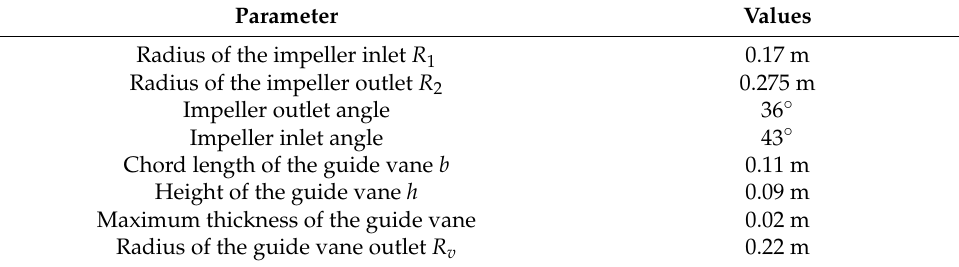
Table 2. The geometrical parameters of the hydrogen